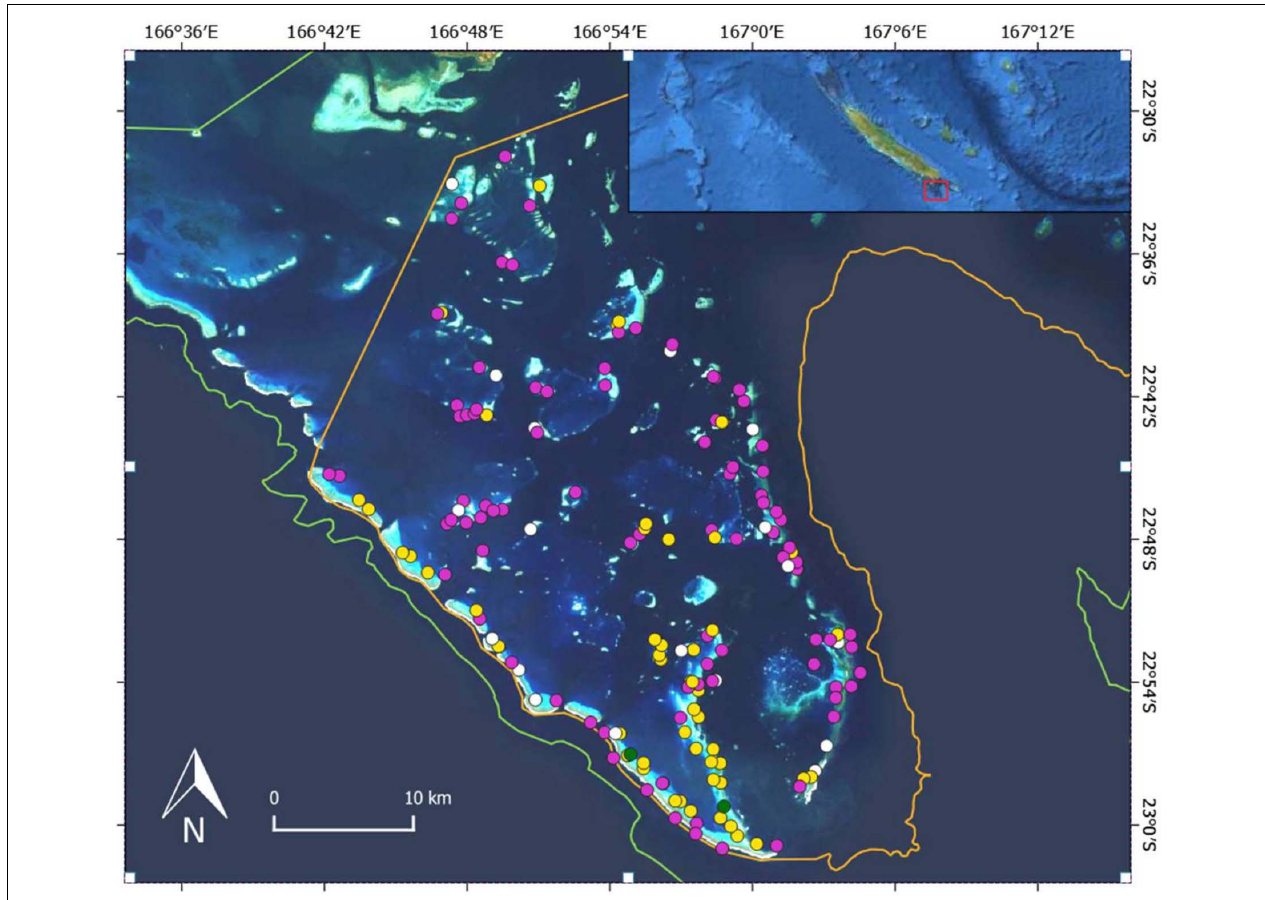
FIGURE 7 | Distribution of habitat types in the Corne Sud, World Heritage property (from Pelletier et al., 2020). The habitats observed in this area are: Live coral (pink), Debris (white), Sandy (yellow). The orange line delineates the Southern Lagoon World Heritage